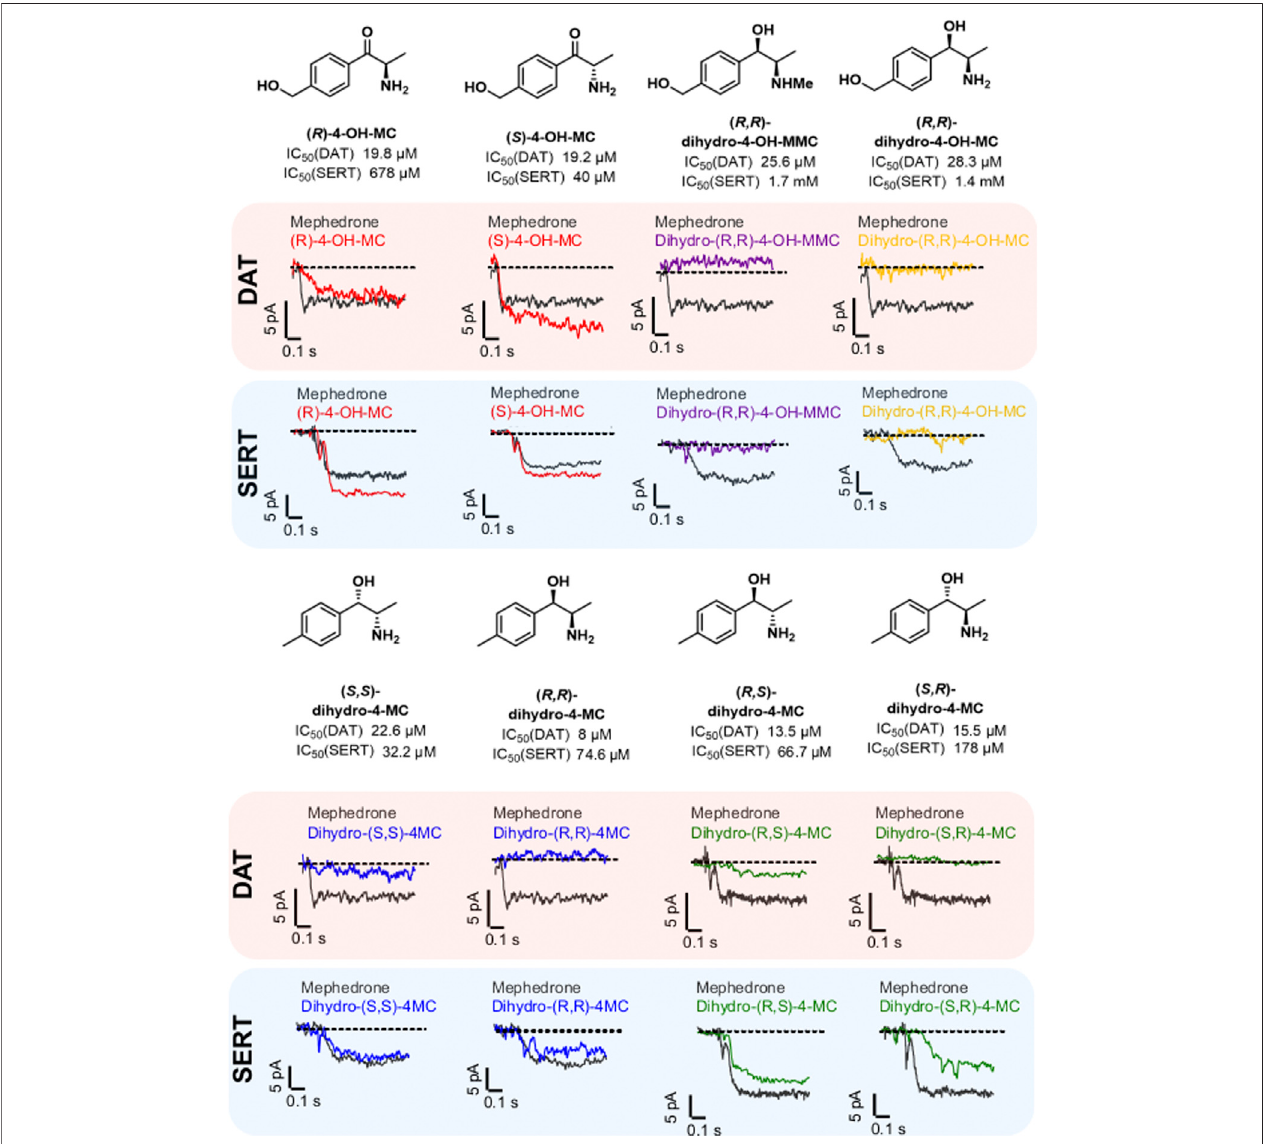
FIGURE 3 | Chemical structure, IC50 values and representative traces of transporter-mediated currents for mephedrone and the selected metabolites. All the metabolites showing an IC50 < 30 µM in one of the two transporters were tested for their ability to elicit transporter-mediated currents. For each of the selected metabolites, representative traces for DAT and SERT are shown below the respective chemical structure. DAT-mediated currents are highlighted by a light-red background, while SERT-mediated currents are highlighted with a light-blue background. The different enantiomers of a speci fi c metabolite are in the same color. All the compounds, including mephedrone, are applied at 30